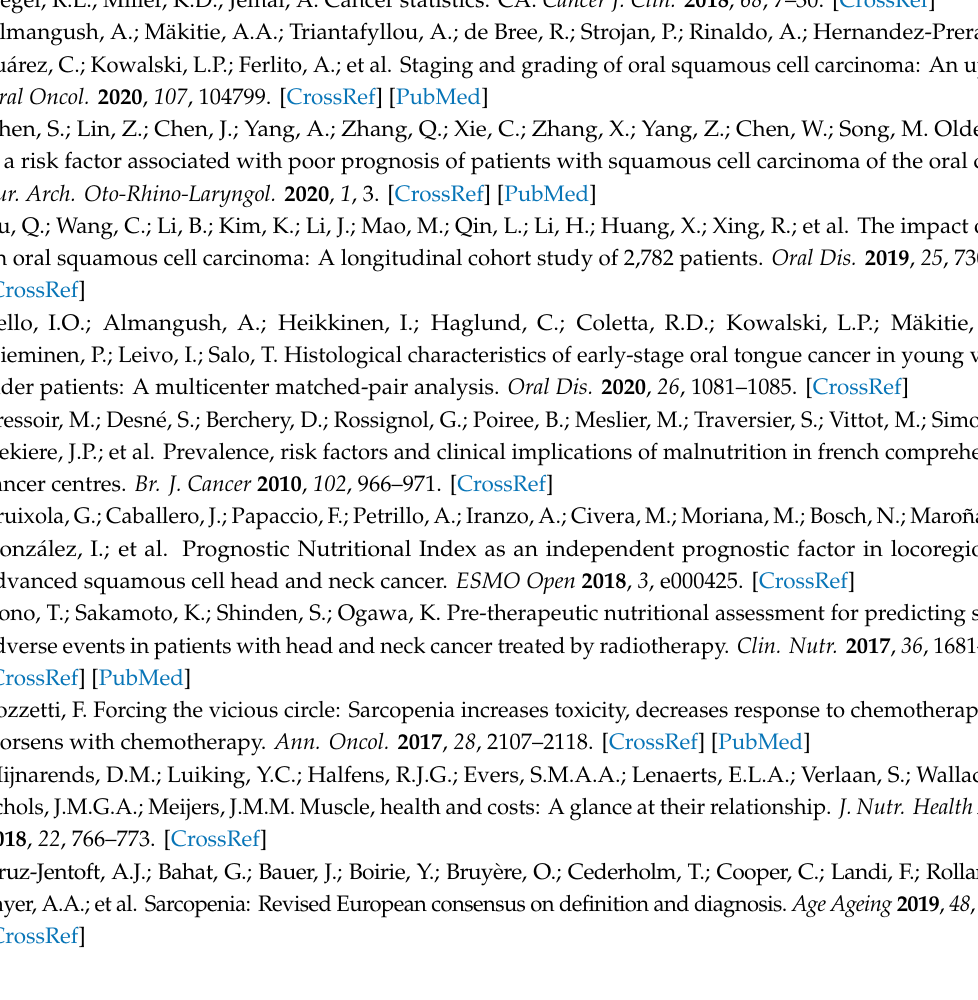
Figure S1: Disease-specific survival rates in patients with OSCC according to PMI and obesity, Figure S2: Survival rates in patients with OSCC according to T and N classification, Table S1 Clinical characteristics classified by PMI and